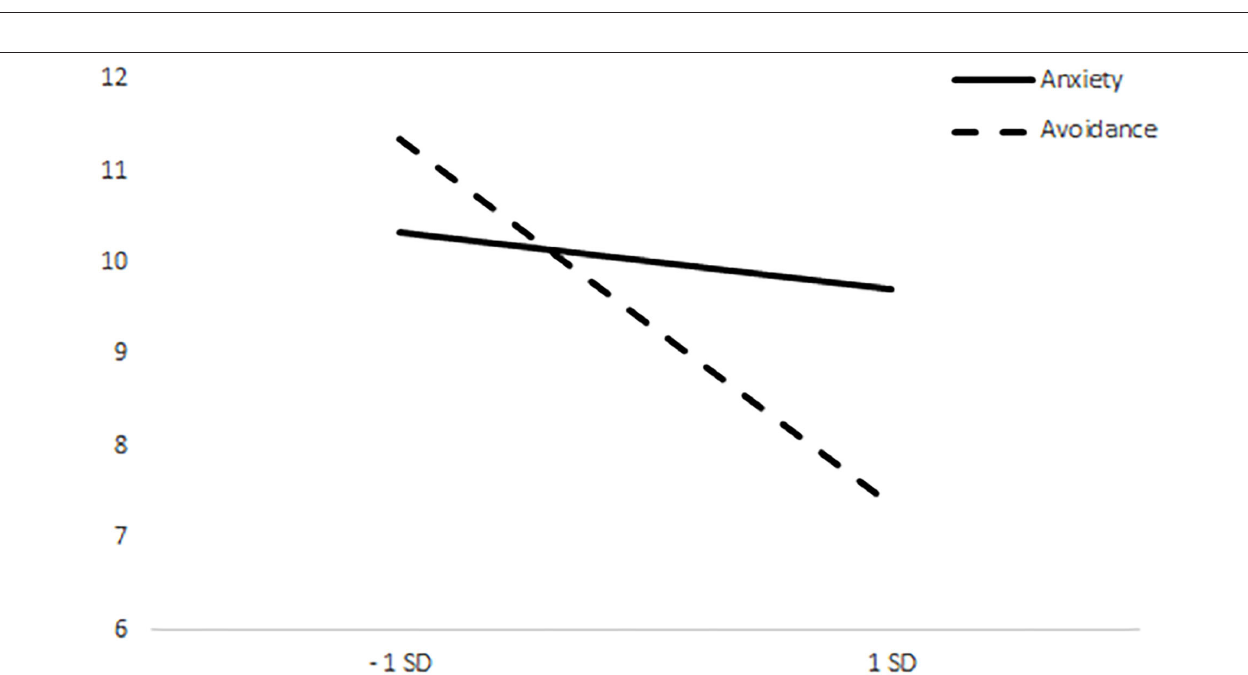
FIGURE 2 | Differences between means of care pictures choices in the threatening condition.